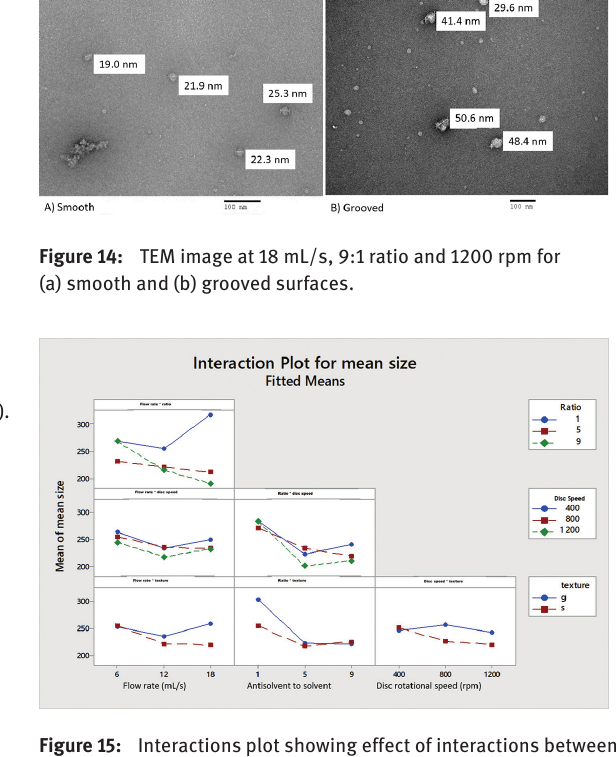
Figure 15: Interactions plot showing effect of interactions between parameters on particle size obtained from the